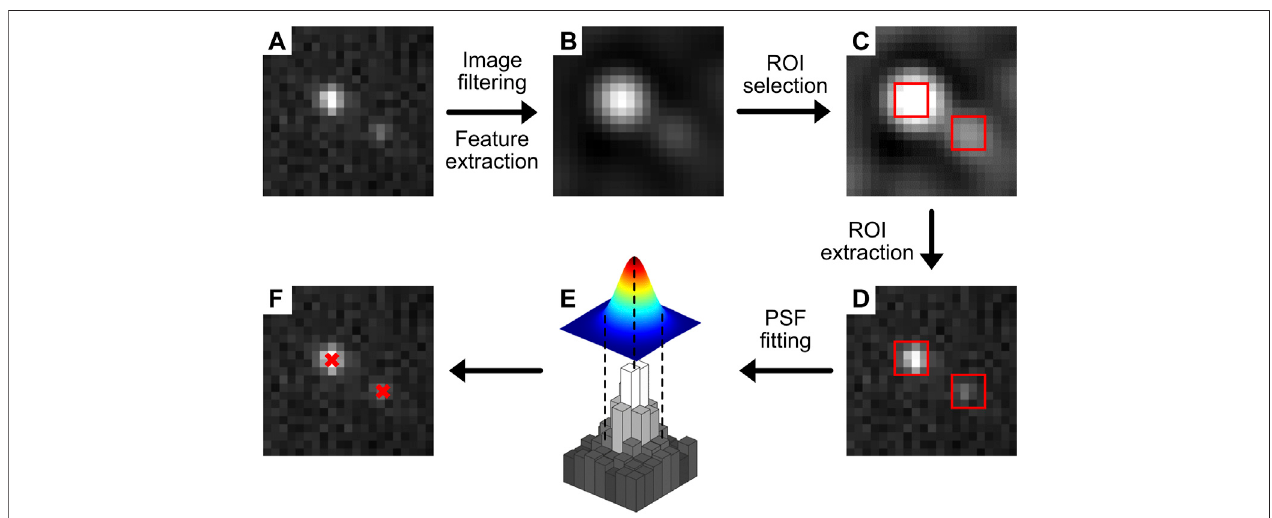
FIGURE 2 | Typical localization methodology. A raw image (A) is fi ltered to enhance features that likely contain emitters (B) . From this fi ltered image, ROIs (red squares) are selected (C) and used to extract the PSF data from the original image (D) . This region is then fi tted by a PSF model (e.g. commonly a 2-dimensional Gaussian) (E) , and the localizations with sub-pixel precision are displayed or used for further analysis (F) .